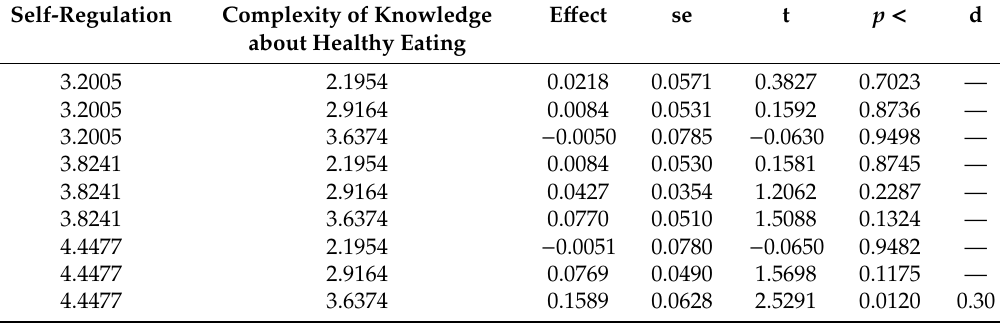
Table 4. Conditional e ff ect of socioeconomic status of family on student’ Body Mass Index at values of the moderators SR (Self-Regulation) and KHE (Complexity of Knowledge about Healthy